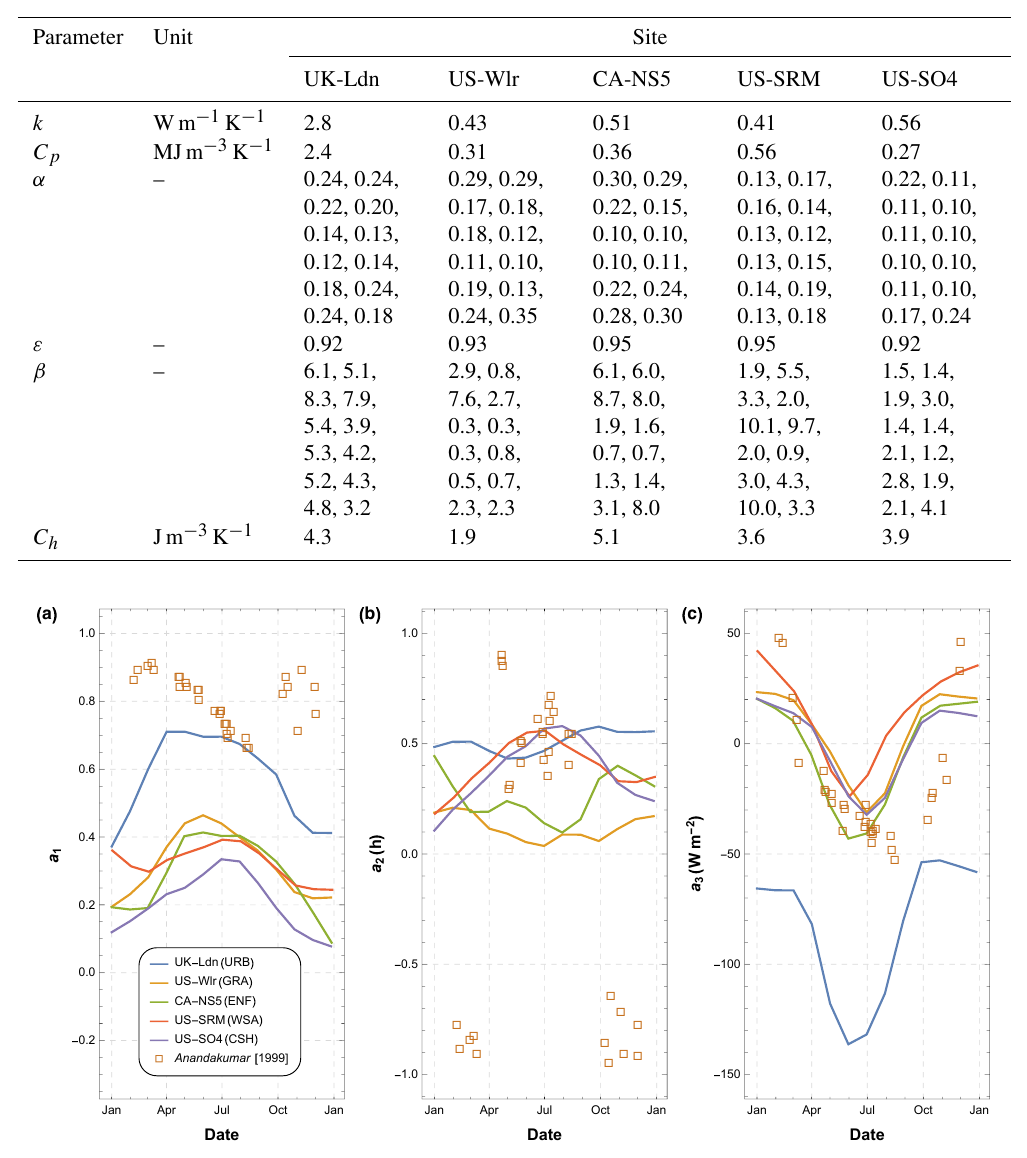
Figure 5. Intra-annual variations of OHM coefficients: (a) a 1 , (b) a 2 , and (c) a 3 . LOESS fits (solid lines) through the daily values predicted by AnOHM and daily values (squares) measured at an asphalt road site (Anandakumar, 1999) are shown. The LOESS (Cleveland and Devlin, 2012) fitting is a locally weighted polynomial regression